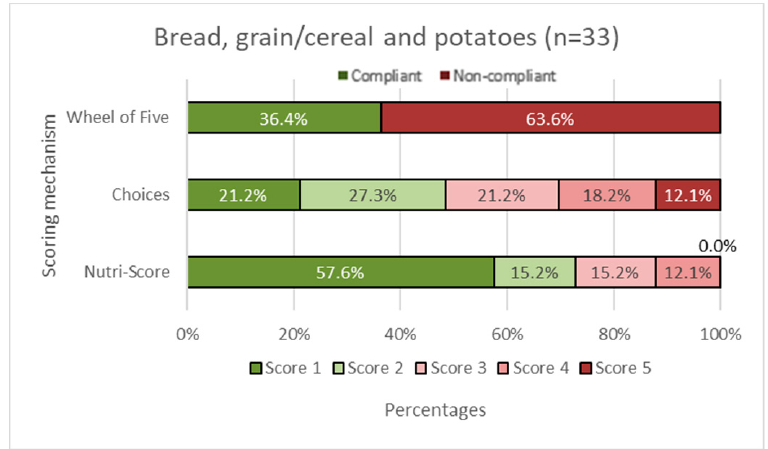
Figure 5. Bread, grain/cereal, and potatoes group. The first horizontal bar shows the percentages of products that are compliant/non-compliant with the Wheel of Five. The Choices score and Nutri-Score show the percentages of products that scored 1 to 5. Nutri-Score 1 equals a score of A, Nutri-Score 2 equals a score of B, etc. Scores 1 and 2 (green shades) are considered healthy (compliant with the Wheel of Five) and scores 3, 4, and 5 (red shades) are considered less healthy (non-compliant with the Wheel of